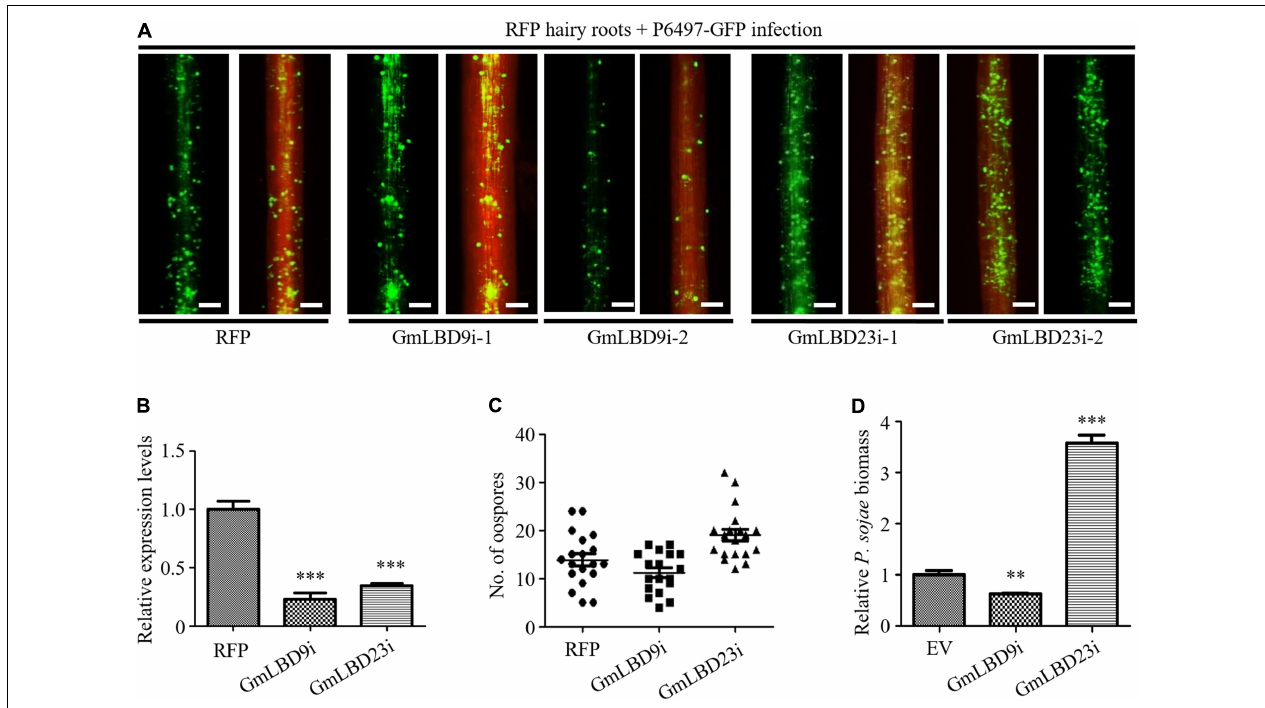
FIGURE 7 | Silencing of GmLBD9 and GmLBD23 showed opposite roles in soybean immunity to P. sojae infection. (A) Hairy roots expressing GmLBD9- and GmLBD23-silenced constructs were selected based on the red fluorescence and then inoculated with P6497-GFP. P. sojae oospores were observed at 48 hpi under a fluorescence microscope. Scale bars represent 0.28 mm. (B) Relative expression of GmLB9 and GmLBD23 in soybean hairy roots was confirmed by qRT-PCR. GmCYP2 gene was used as an internal control. (C) The number of oospores was observed under fluorescence microscopy and counted. (D) Relative biomass of P. sojae was determined by qPCR at 48 hpi. Error bars indicate three biological replicates ( ∗∗ P < 0.01; ∗∗∗ P < 0.001; one-way